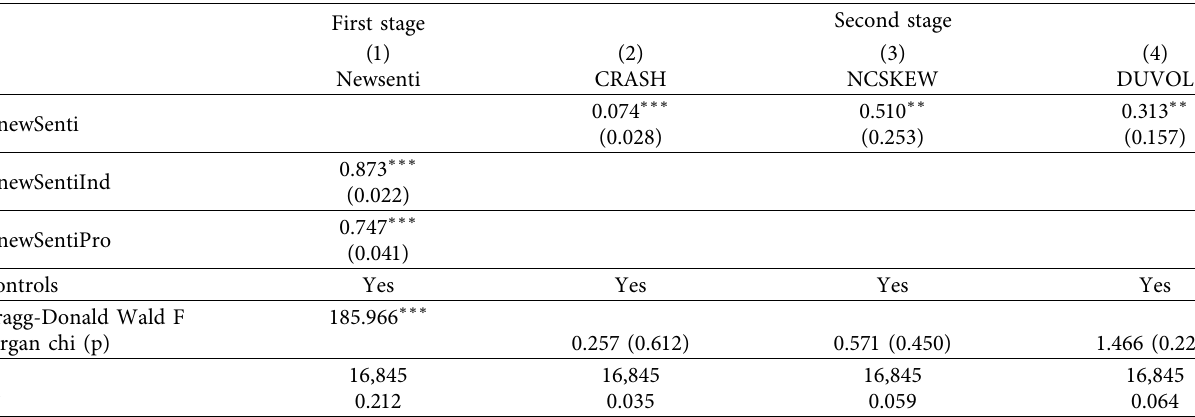
Table 7: Two stages OLS